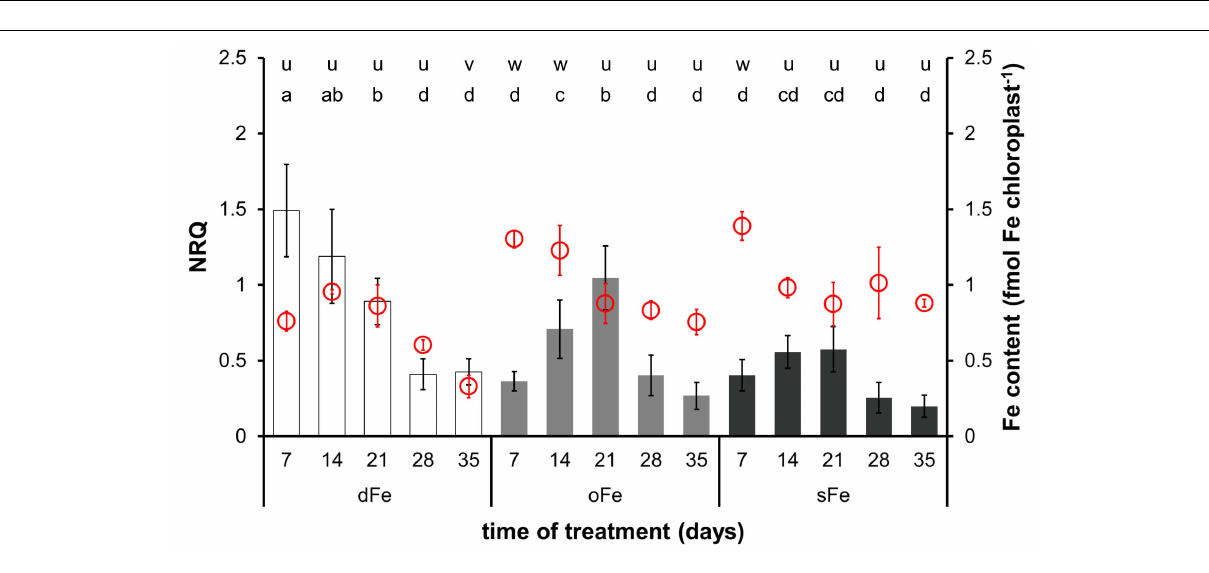
FIGURE 5 | Expression of BnFRO7 (bar graph, left scale) and Fe content of chloroplasts (scatter plot in red, right scale) in the 6th leaves of plants grown on deficient (dFe), optimal (oFe) and supraoptimal (sFe) Fe supply, represented by open, light grey and dark grey columns, respectively. Error bars represent SD values. To compare differences between times of measurements, one-way ANOVAs were performed with Tukey–Kramer multiple comparison post hoc test (expression: P < 0.05, n = 12; Fe content: P < 0.05, n = 9), indicated by letters (NRQ: a–d; Fe content: